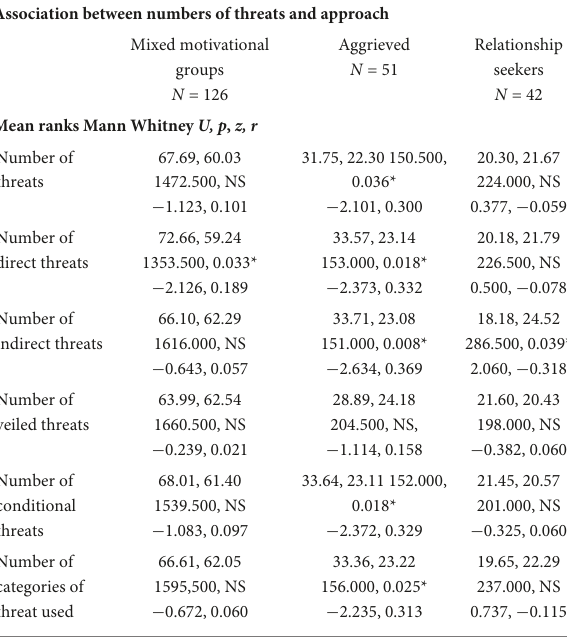
TABLE 5 Associations between Mullen threat categories and